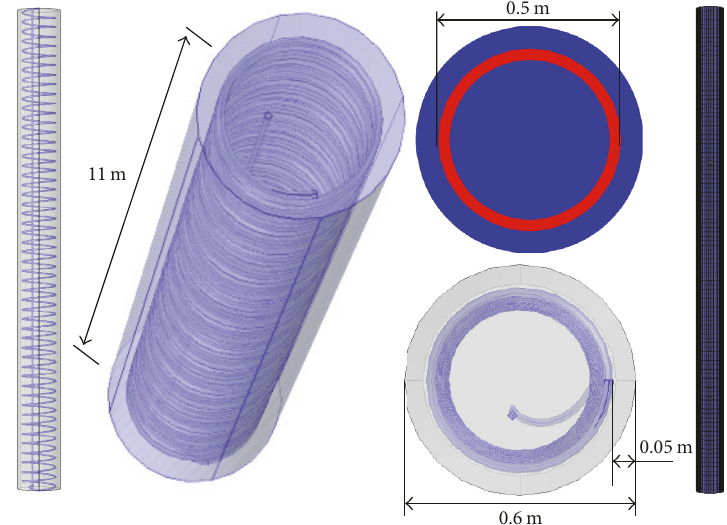
Figure 10: Conceptual model and simulation model of energy pile.